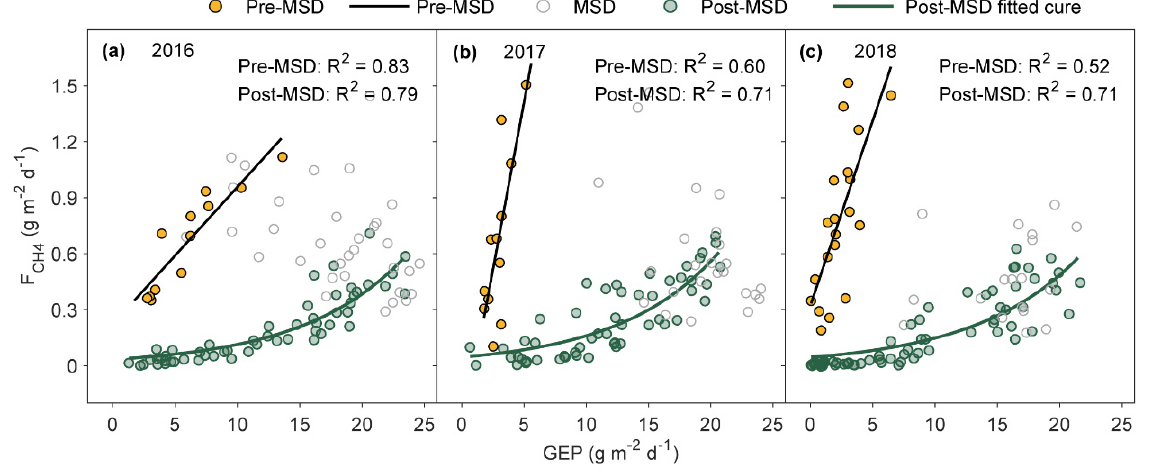
Figure 4. Linear and exponential regression models of daily CH 4 fluxes against GEP for the periods before (yellow points) and after (green points) the mid-season drainage, respectively. The grey circles ( a – c ) represent CH 4 fluxes during mid-season drainage each year. Table 2. The results of Partial F test for daily CH 4 fluxes and other variables before and after the mid-season drainage.